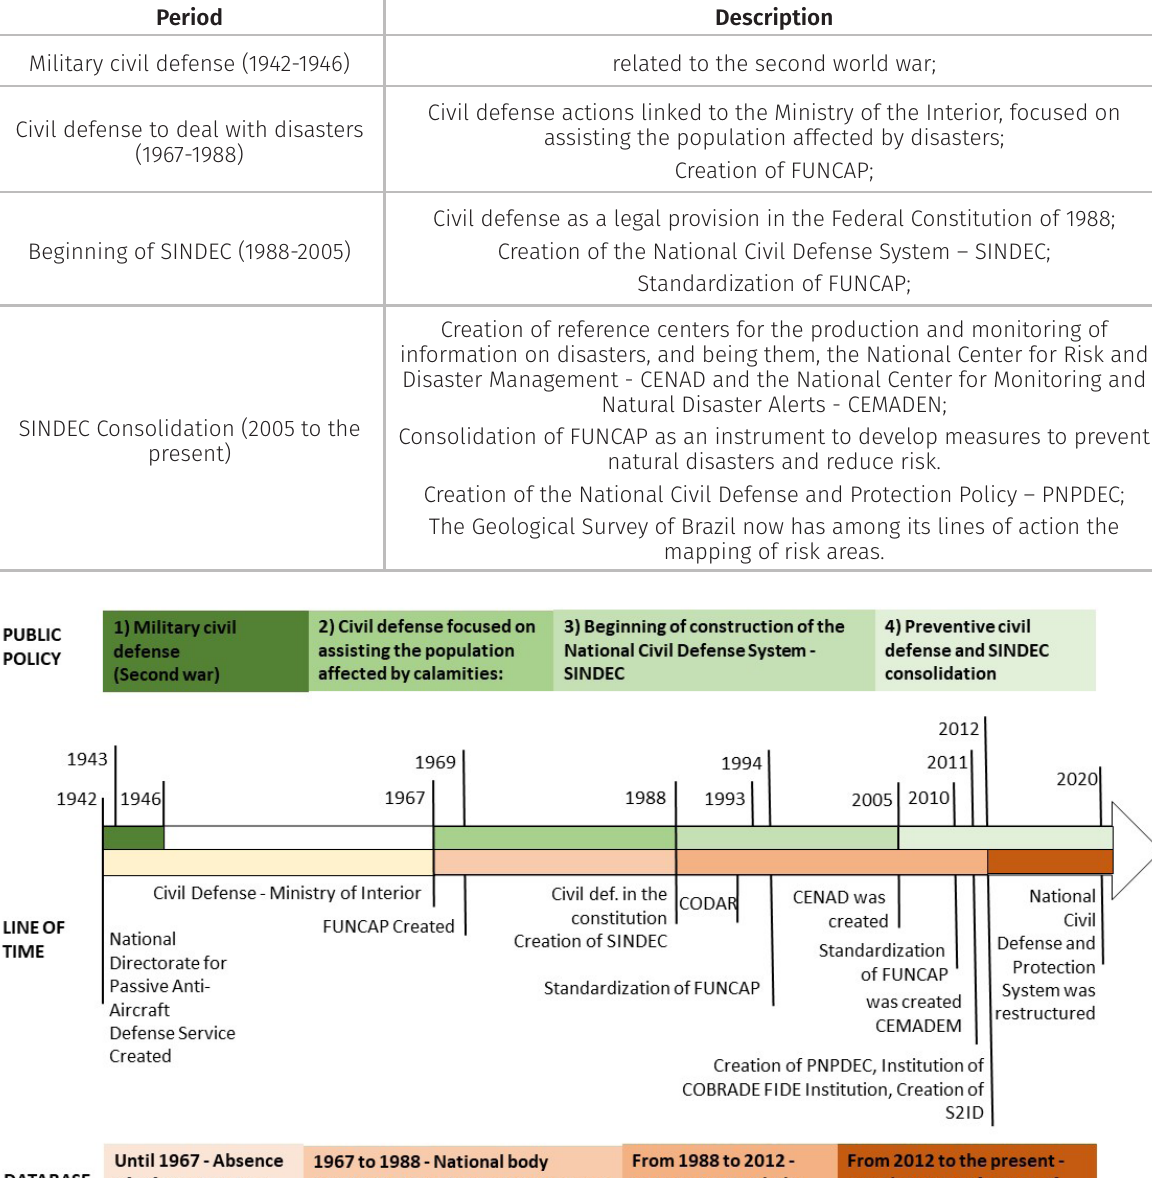
Table I. division of periods related to the evolution of civil defense in Brazil. Period